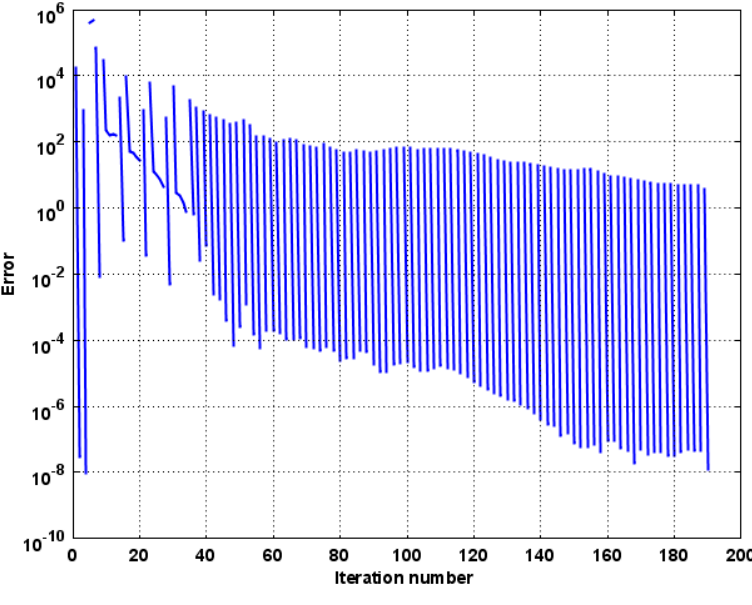
Figure 6. Error Figure 6. Error plot.